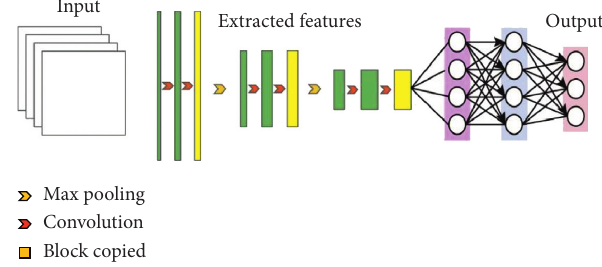
Figure 1: The typical architecture of